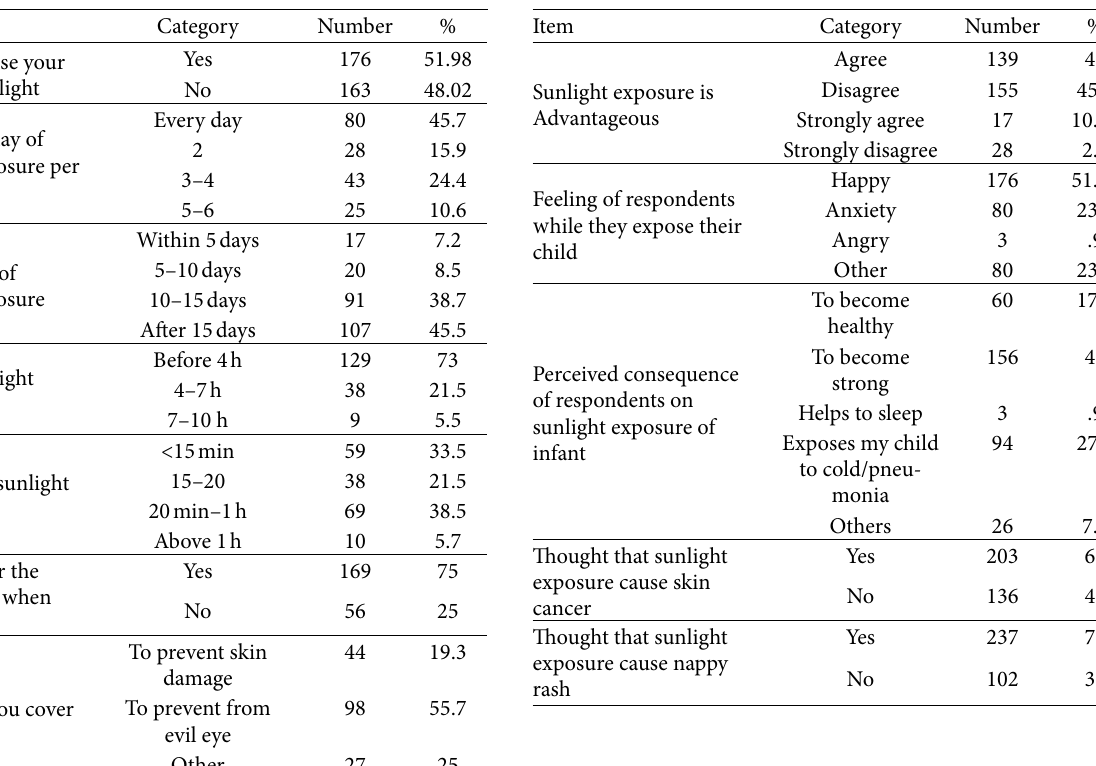
Table 4: Practice of respondents on sunlight exposure of infant in Farta woreda, Northwest Ethiopia, 2018.